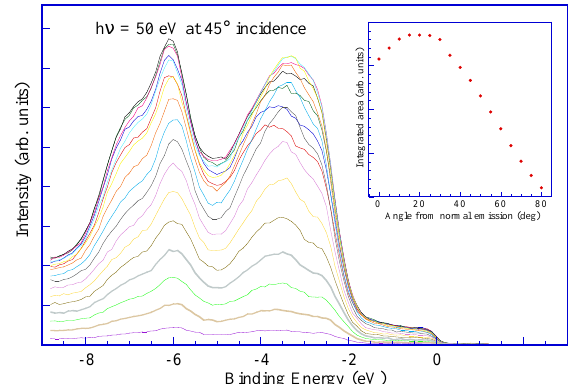
FIG. 4. (Color) The angle-resolved valence band photoemission spectra from clean Au taken with 50 eV photons, referenced to the Fermi level. The energy integrated intensity as a function of emission angle is shown in the